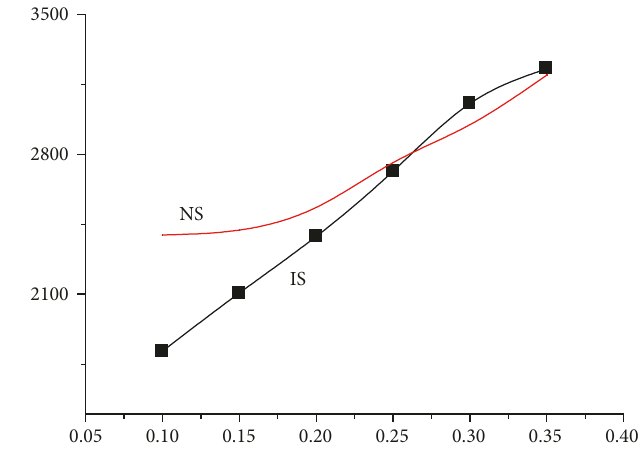
Figure 10: Yield uncertainty versus the supply chain’s costs under two cases.